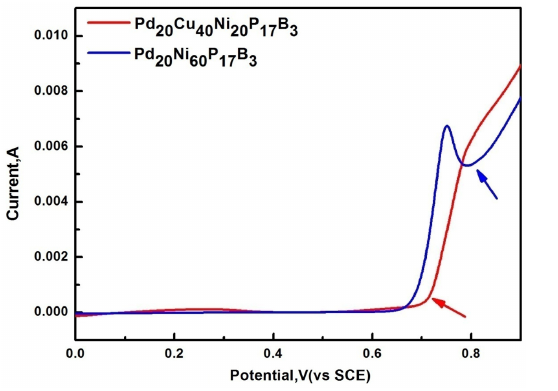
Ni P B and Pd Ni Cu P B 20 60 17 3 20 20 40 17 3 SO + 0.2 mol·L –1 Figure 2. current vs time curves of the Pd 2 4 metallic glasses in 0.8 mol·L –1 H